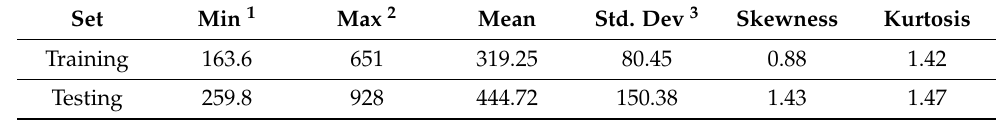
Table 2. Descriptive statistics for the COVID-19 pandemic training and testing periods.